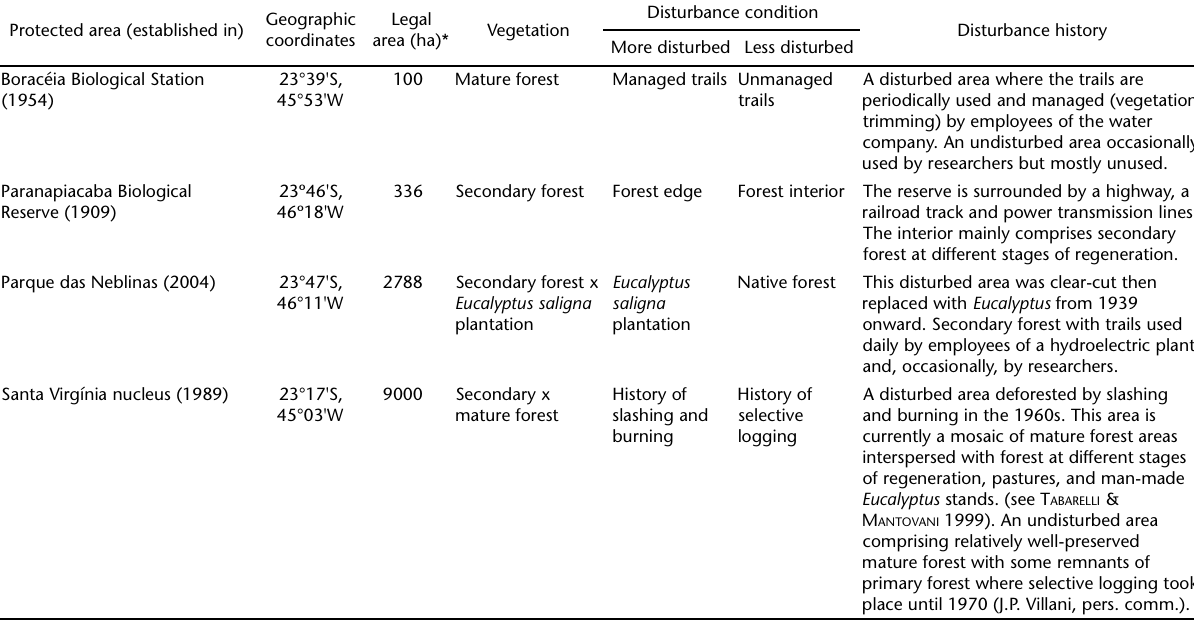
Table I. Main characteristics of the four studied protected areas in the Serra do Mar vegetation complex. * All located in a continuum along the Serra do Mar vegetation complex; see figure 1. Geographic Protected area (established in)